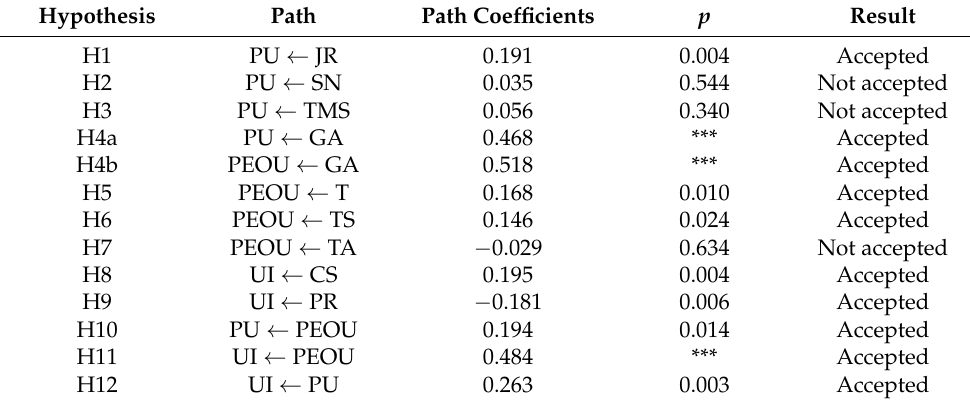
Table 6. Tests of